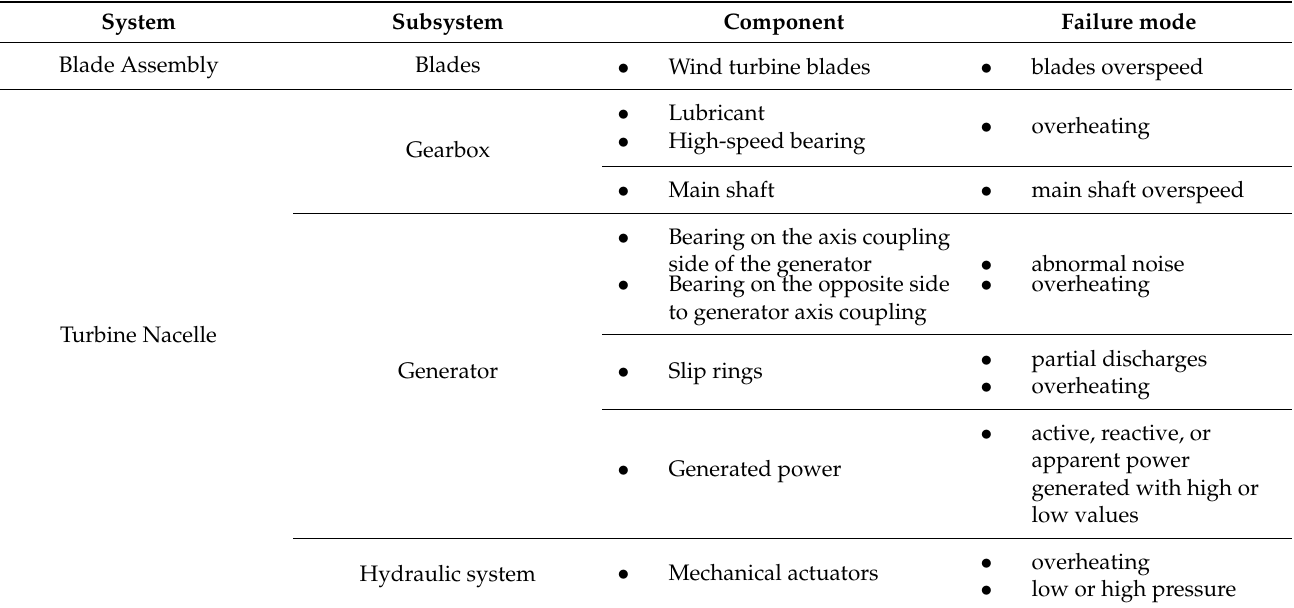
Table 2. Systems, subsystems, components, and failure modes of wind turbines. System